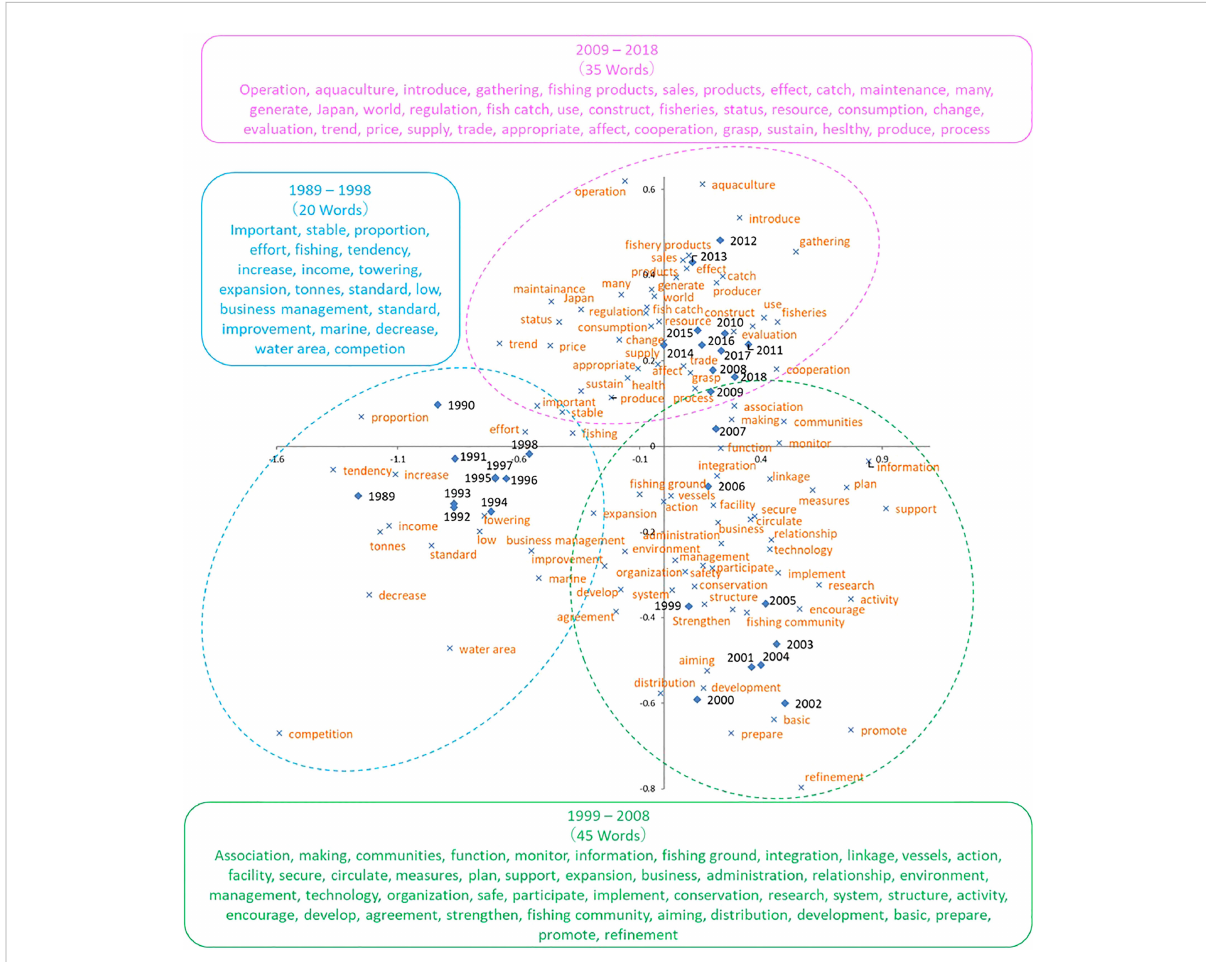
FIGURE 2 Results of correspondence analysis using frequently mentioned words in fi sheries policy white papers (1989 –